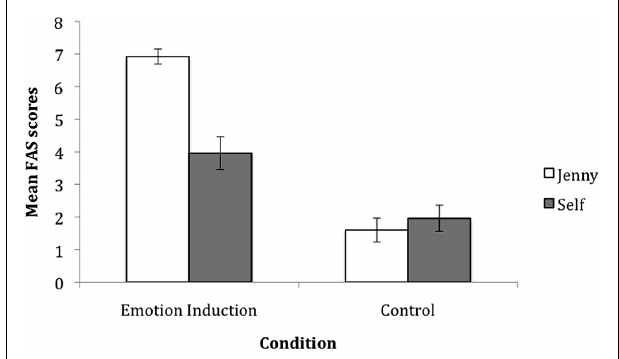
FIGURE 1 | Mean ratings for Jenny and self on the FacialAffective Scale (FAS), with standard error bars, for the emotion induction and control group in study one (5–6 year-olds). Possible scores ranged from “0” (very happy) to “8” (very